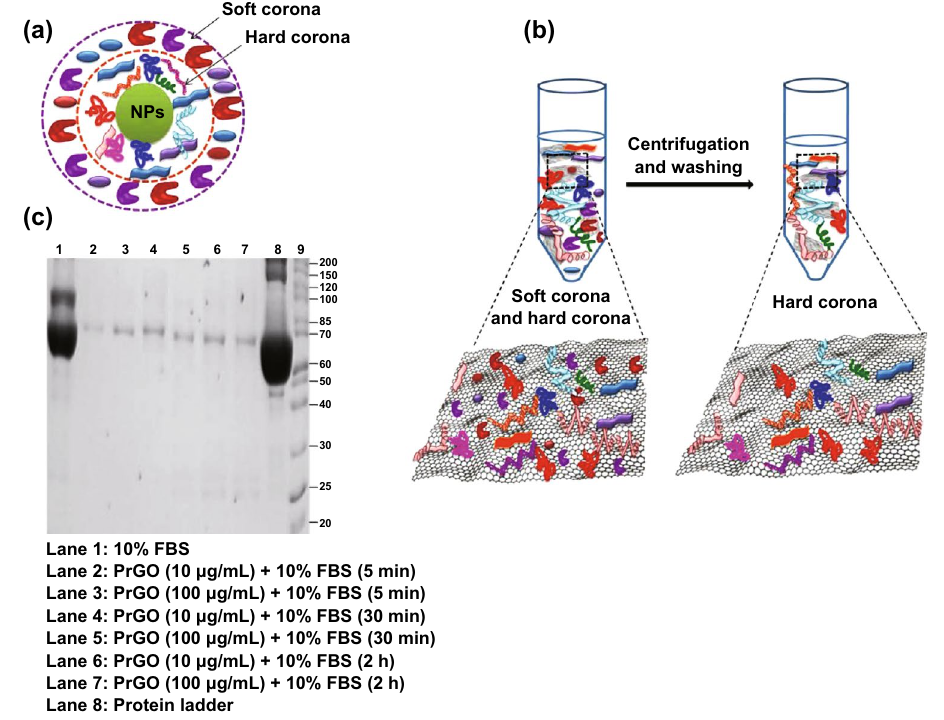
Fig. 7 Protein corona. a Formation of a hard and a soft corona on the surface of nanoparticles, following the incubation of nanoparticles with serum. b Isolation and separation of hard corona proteins that bind to graphene sheets by repeated centrifugation and washing. c SDS- PAGE analysis of hard corona proteins isolated from PRGO incubated with FBS at different time periods (5 min, 30 min, and 2 h). Only BSA (~ 66 kDa) formed a hard corona by strongly binding onto the surface of PRGO under different reaction